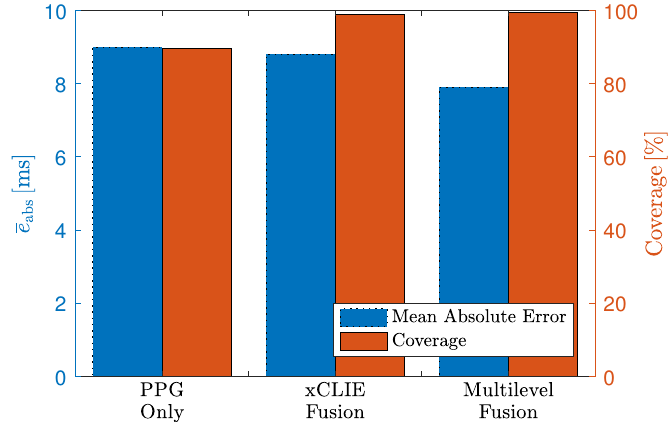
Figure 12. Influence of the parameter ∆ th on the absolute interval estimation error e abs . A threshold of ∆ = 0 means using only xCLIE, ∆ → ∞ means only intervals obtained via P&T applied to cECG th th are chosen. In the final implementation, ∆ th = 40ms was used.